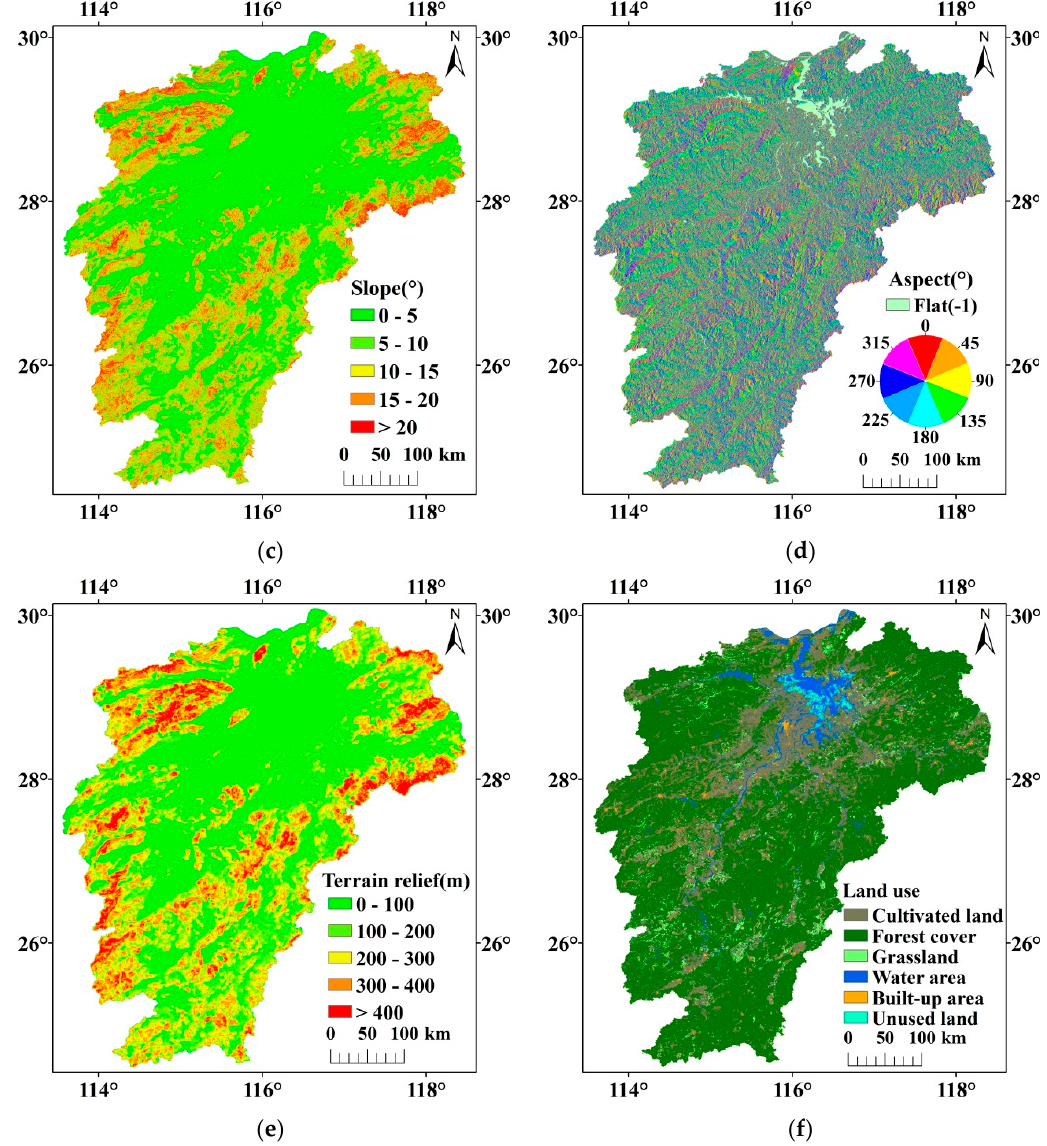
Figure 1. Study site and datasets: ( a ) location of Jiangxi province, ( b ) Shuttle Radar Topography Mission (SRTM) digital elevation model (DEM) and Geoscience Laser Altimeter System onboard the Ice, Cloud, and land Elevation Satellite (ICESat / GLAS) data, ( c ) terrain slope, ( d ) terrain aspect, ( e ) terrain relief, and ( f ) land use.